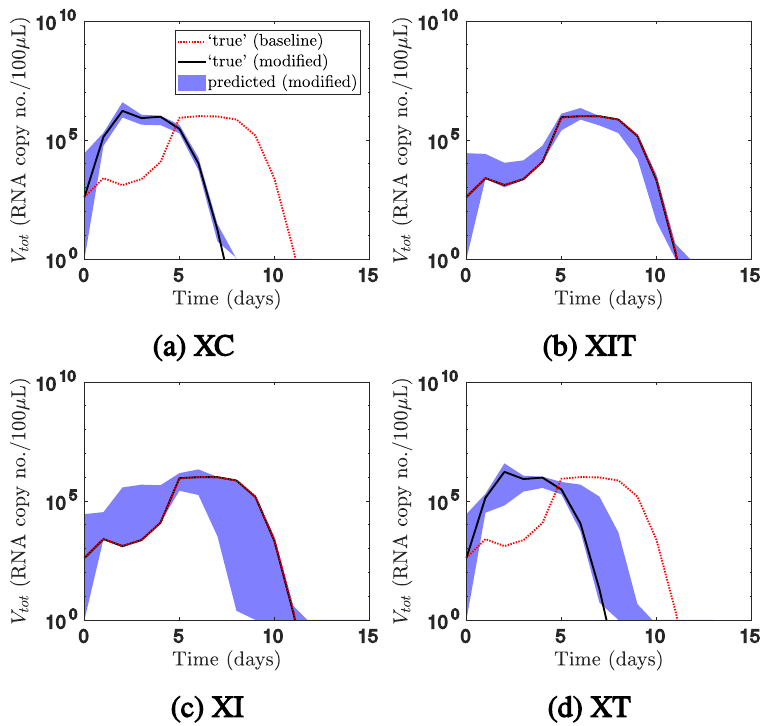
Fig 5. Predictions of the challenge viral load for a one-day inter-exposure interval when the mechanisms mediating cross-protection were restricted. The black solid lines show the challenge viral load for the ‘true’ parameter values when the mechanisms mediating cross-protection were restricted using (a) model XC, (b) model XIT, (c) model XI, or (d) model XT. The red dotted lines show the viral load for the baseline model. Comparing the two sets of lines revealed that innate immunity mediated cross-protection, whereas cellular adaptive immunity and target cell depletion did little to mediate cross-protection. The model fitted to sequential infection data accurately predicted the challenge outcomes for models XC and XIT, but not model XI or model XT (95% prediction intervals shown). It thus correctly attributed cross-protection to target cell depletion and/or innate immunity, but could not definitively distinguish between the two. For clarity, the viral load for the primary infection is not presented in this